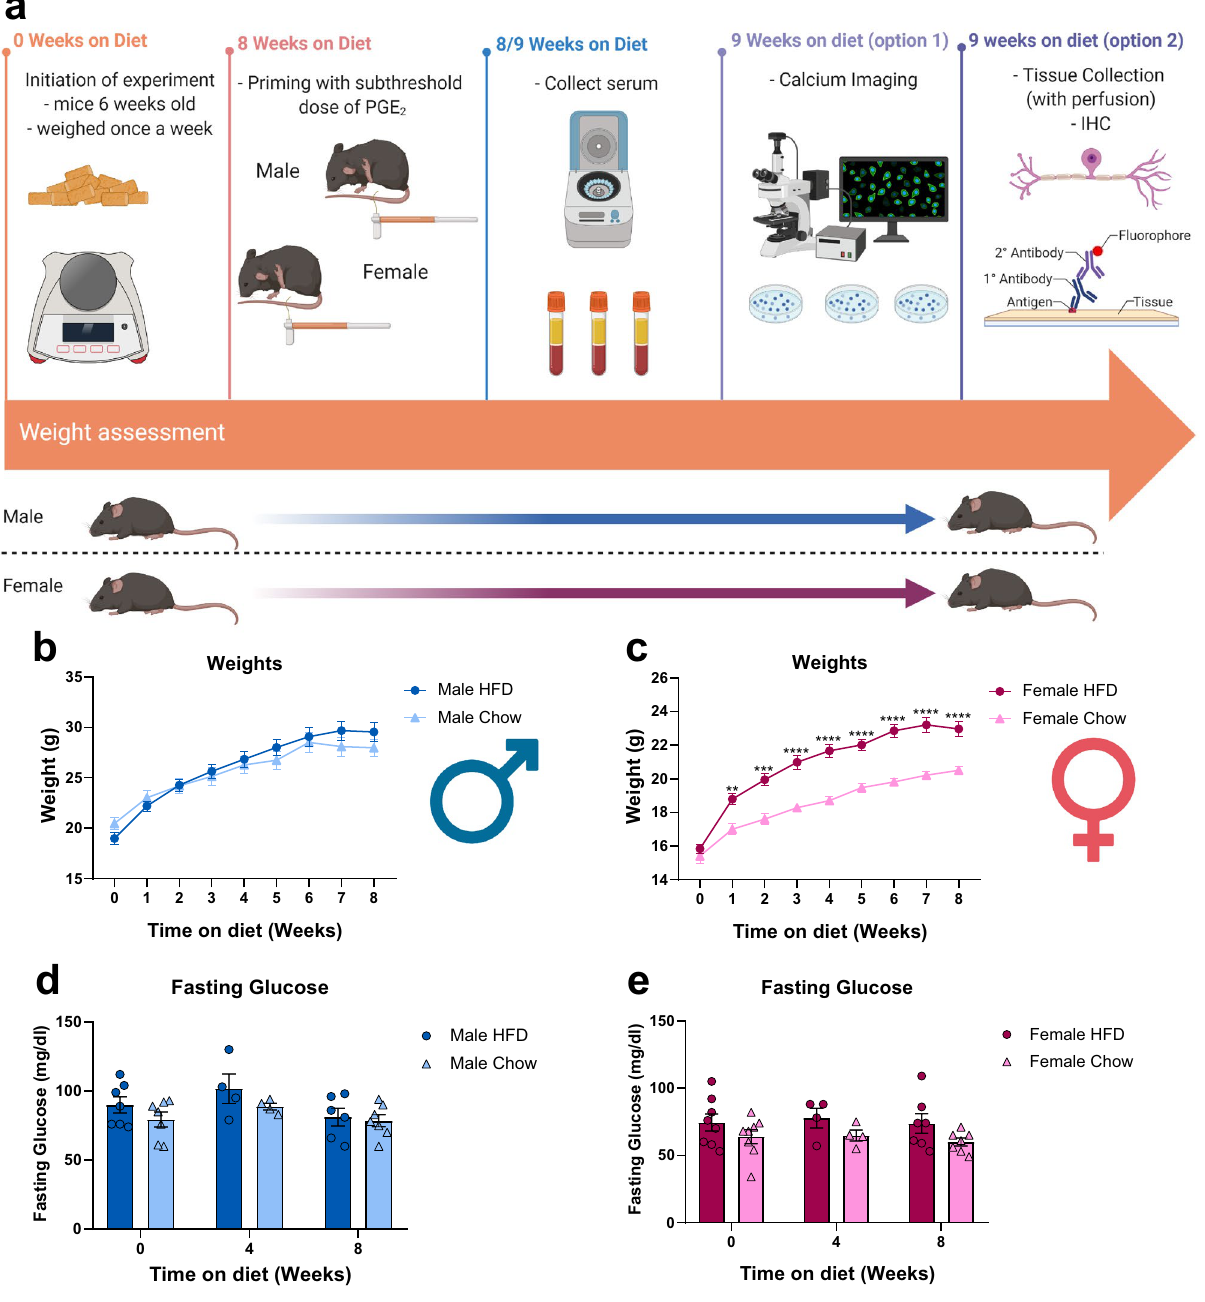
Figure 1. A short term HFD regime does not induce the development of obesity nor hyperglycemia. ( a ) Mice were assigned either a HFD or chow diet at 6 weeks of age for 9 weeks. Weight assessment was performed weekly and blood glucose measurements were performed every weeks starting at week zero. On week 8, mice received a subthreshold dose (0.005 mg/mL) of PGE 2 via intraplantar injection and mechanical hypersensitivity was measured afterwards using von Frey. In addition, serum was collected on week 8 and 9 to assess plasma FFA levels. On week 9, tissues were collected and were used either for calcium imaging or immunohistochemistry. ( b , c ) HFD males (n = 14) did not gain significantly more weight than their chow counterparts (n = 14) whereas HFD females (n = 15) did gain significantly more weight than their chow counterparts (n = 14); both did not reach levels of obesity. *p < 0.05; **p < 0.01; ***p < 0.001; ****p < 0.0001 (Two-way ANOVA with Sidak’s post hoc comparison). ( d , e ) No significant developments occurred in their fasting glucose levels between HFD males (n = 7) and chow males (n = 7) nor between HFD females (n = 8) and chow females (n =